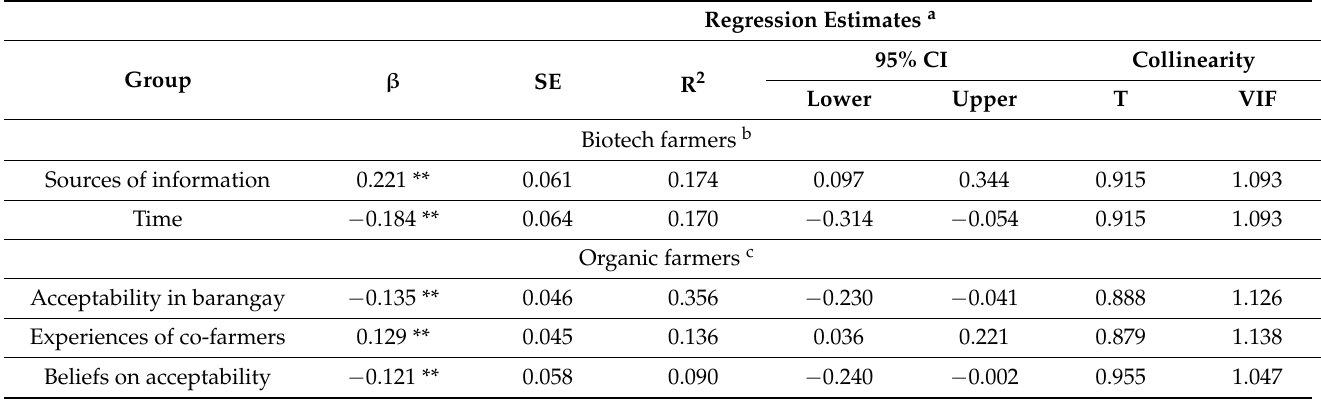
Table 5. Stepwise regression estimates of influential factors on the coexistence perspective within biotech farmers (BF; n = 35) and organic farmers (OF; n =